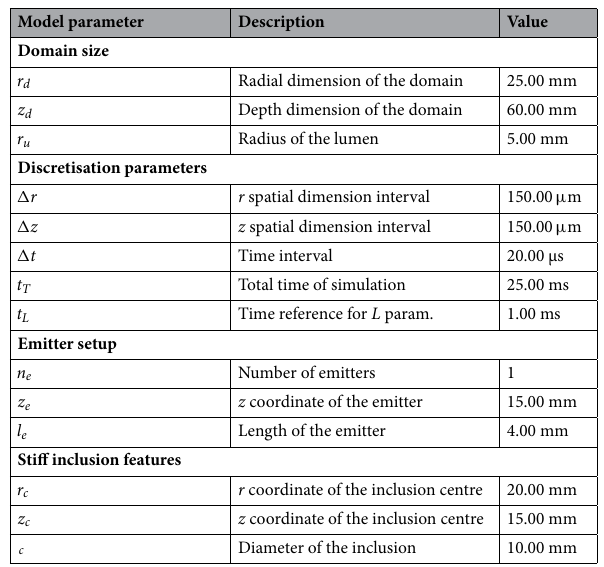
Table 1. Values of the model parameters. Further detail in Gomez et al. 4 .